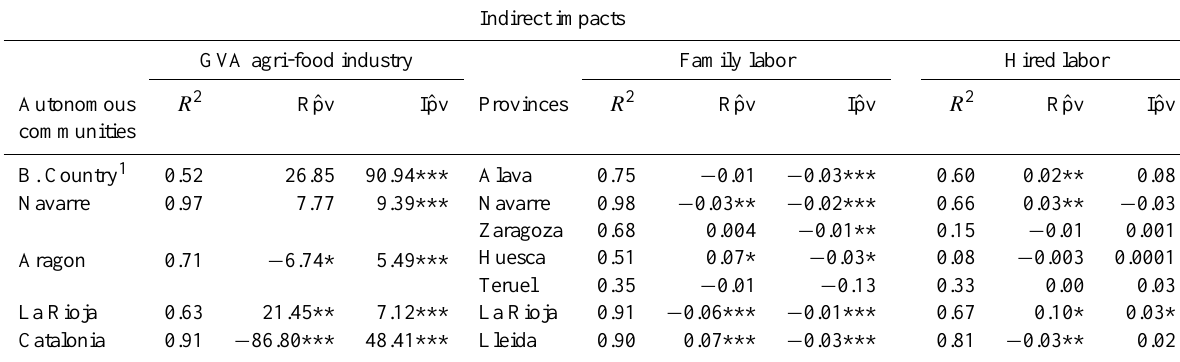
Table 3. Regression results of two step models for indirect impacts of drought: agri-food industrial GVA (regional level) and employment (provincial level). Correlation coefficients and significance of explanatory